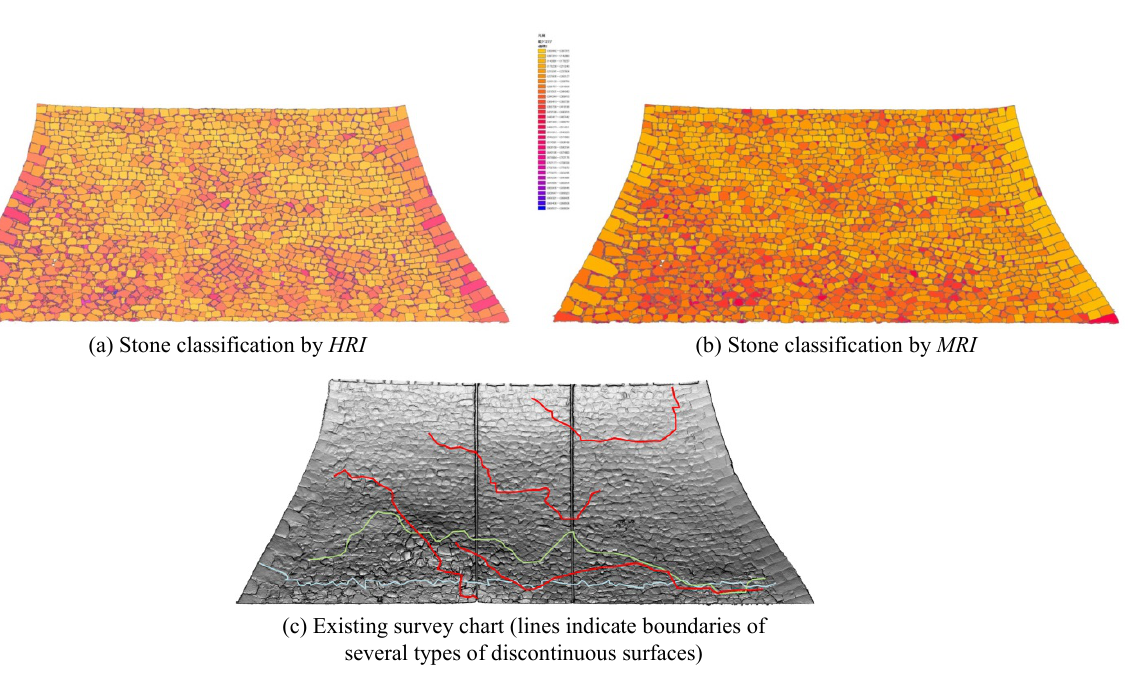
Figure 10. Contrast between irregular-shape indexes and existing survey